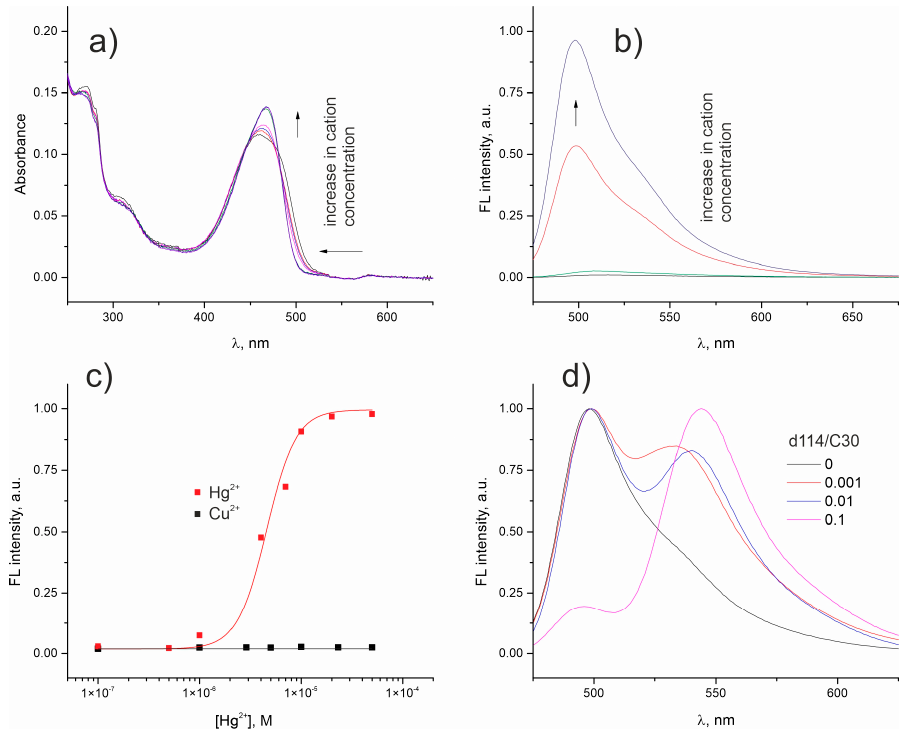
Figure 3. The change in absorption ( a ) and luminescence ( b ) spectra of C30/F12 1/2 NPs in aqueous solution (pH = 6) upon addition of Hg 2+ . The dependence of luminescence intensity of C30/F12 1/2 NPs on Hg 2+ and Cu 2+ concentration ( c ). The luminescence spectra of C30/F12 NPs doped with different amount of d114 ( d ).